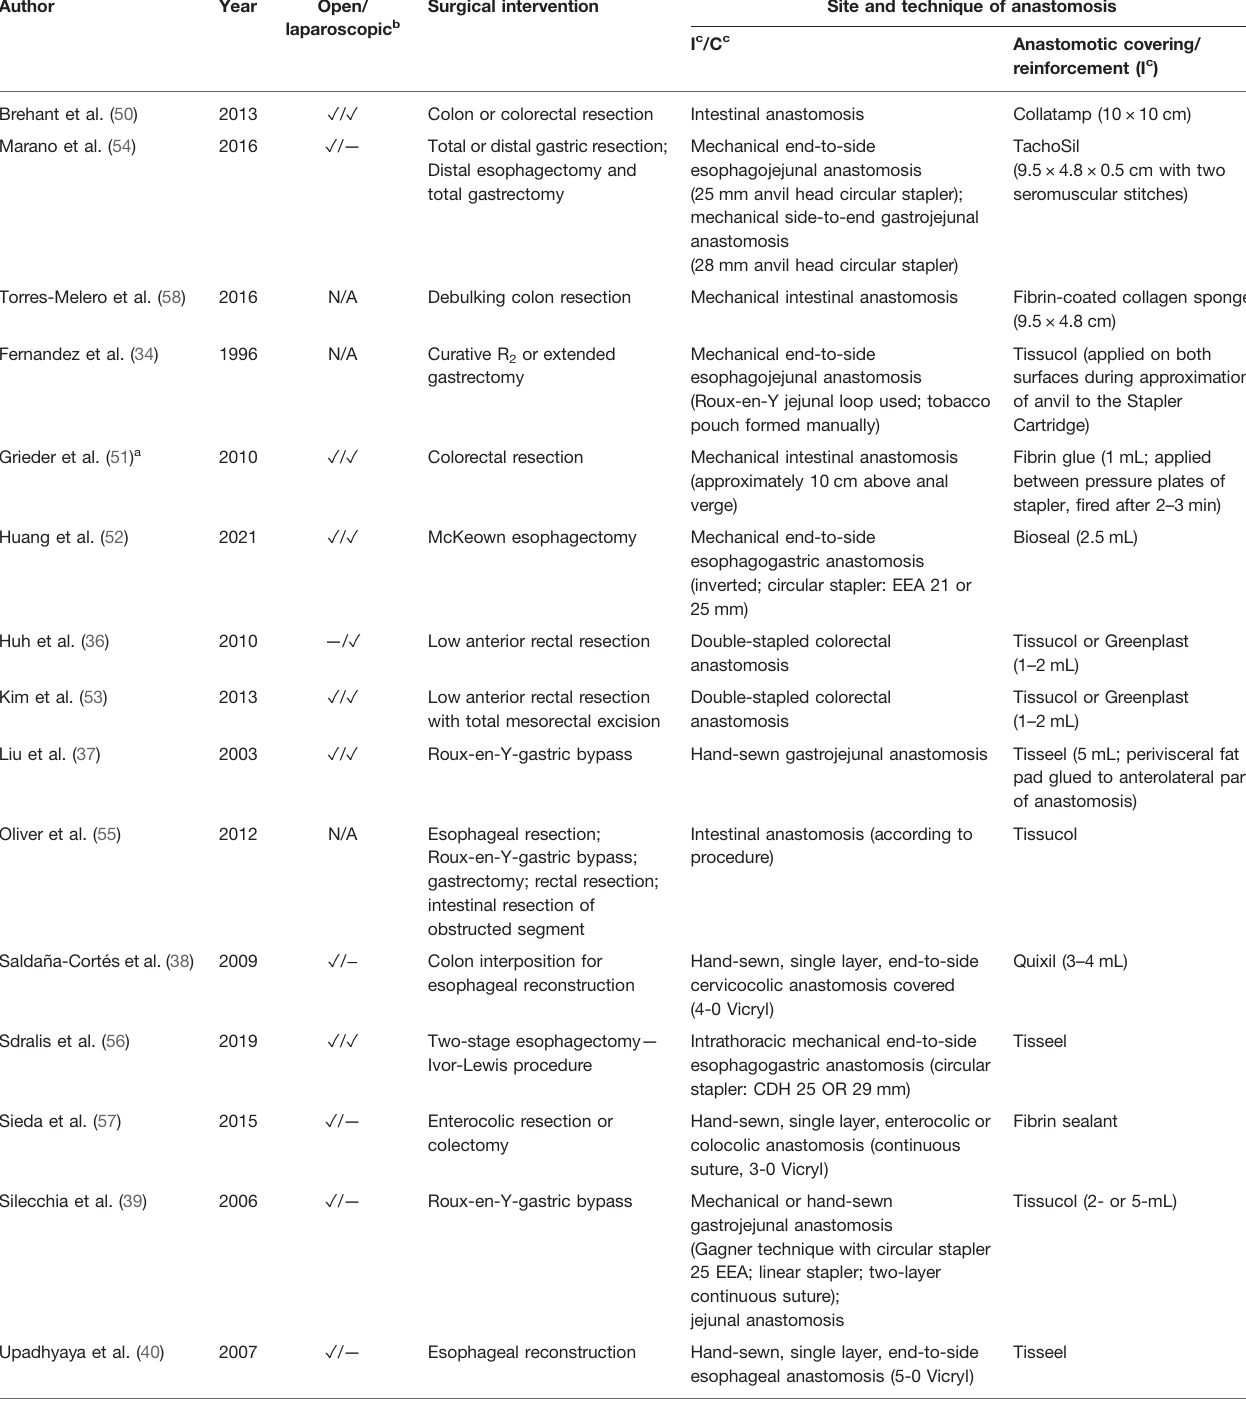
TABLE 2 | Surgical